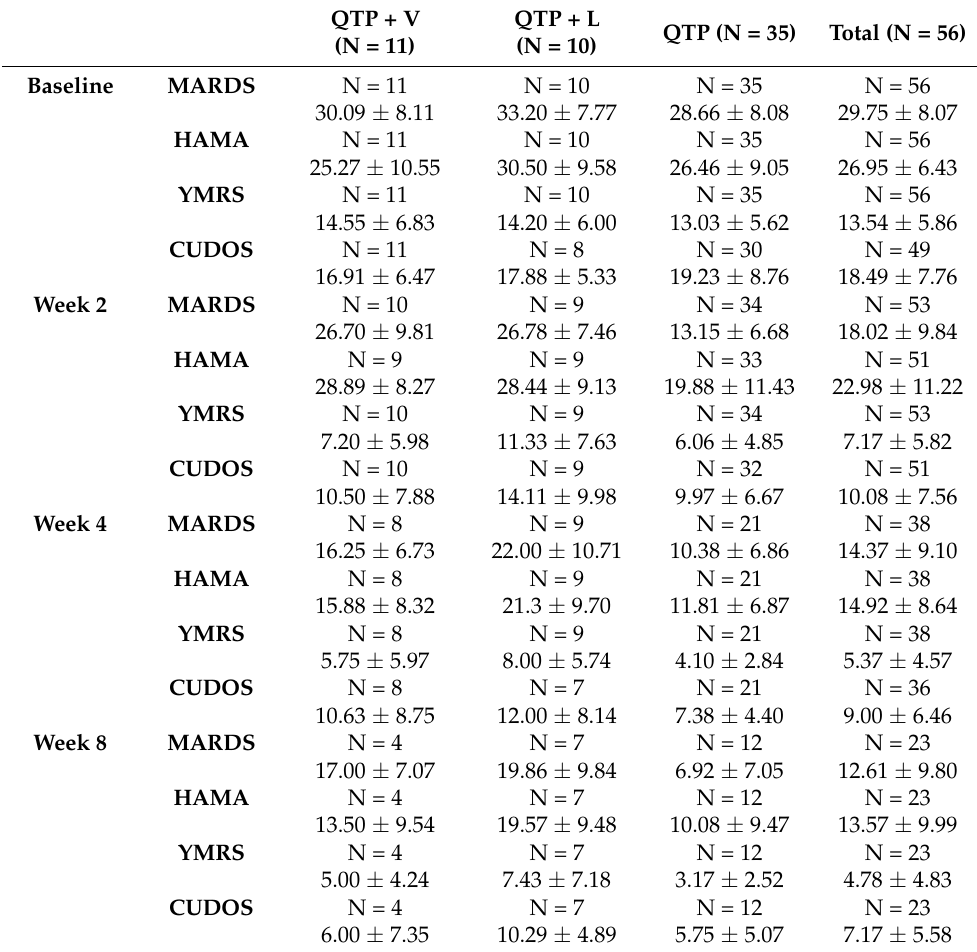
Table 2. Total scores of HAMA, YMRS, MARDS, CUDOS of three groups at enrolment, two weeks and eight weeks (Mean ±